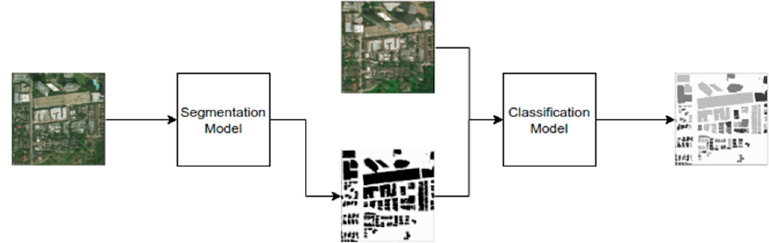
Figure 1. Pipeline for classifying damage magnitude to buildings from satellite images.